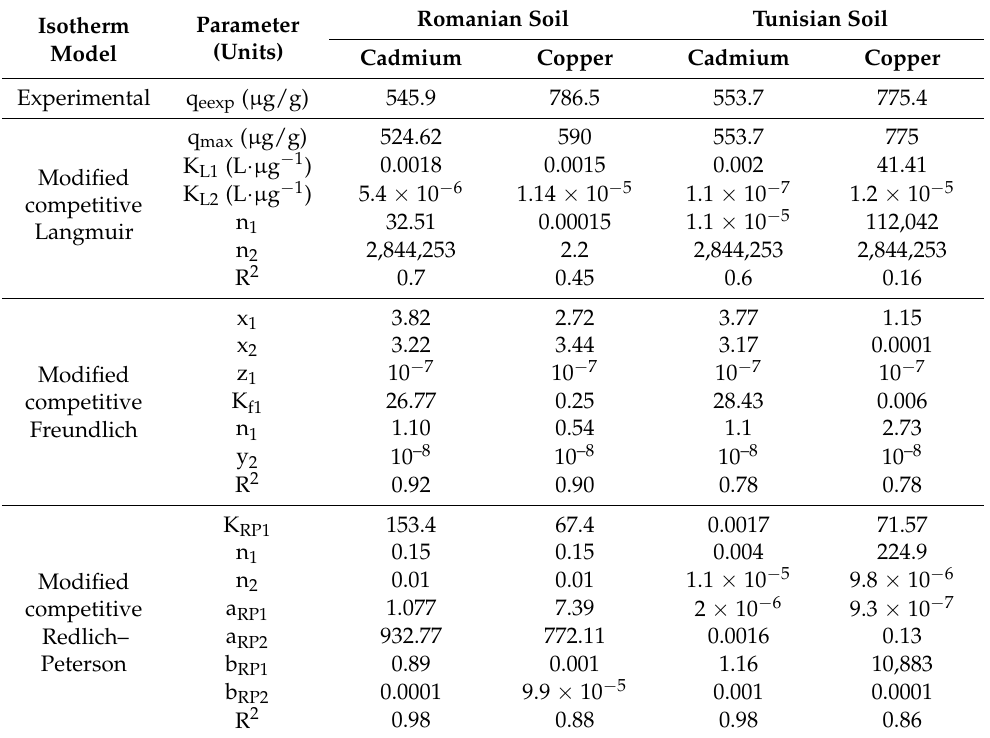
Table 4. Fitting of the binary isotherm parameters of cadmium and copper adsorption in Tunisian and Romanian soils.